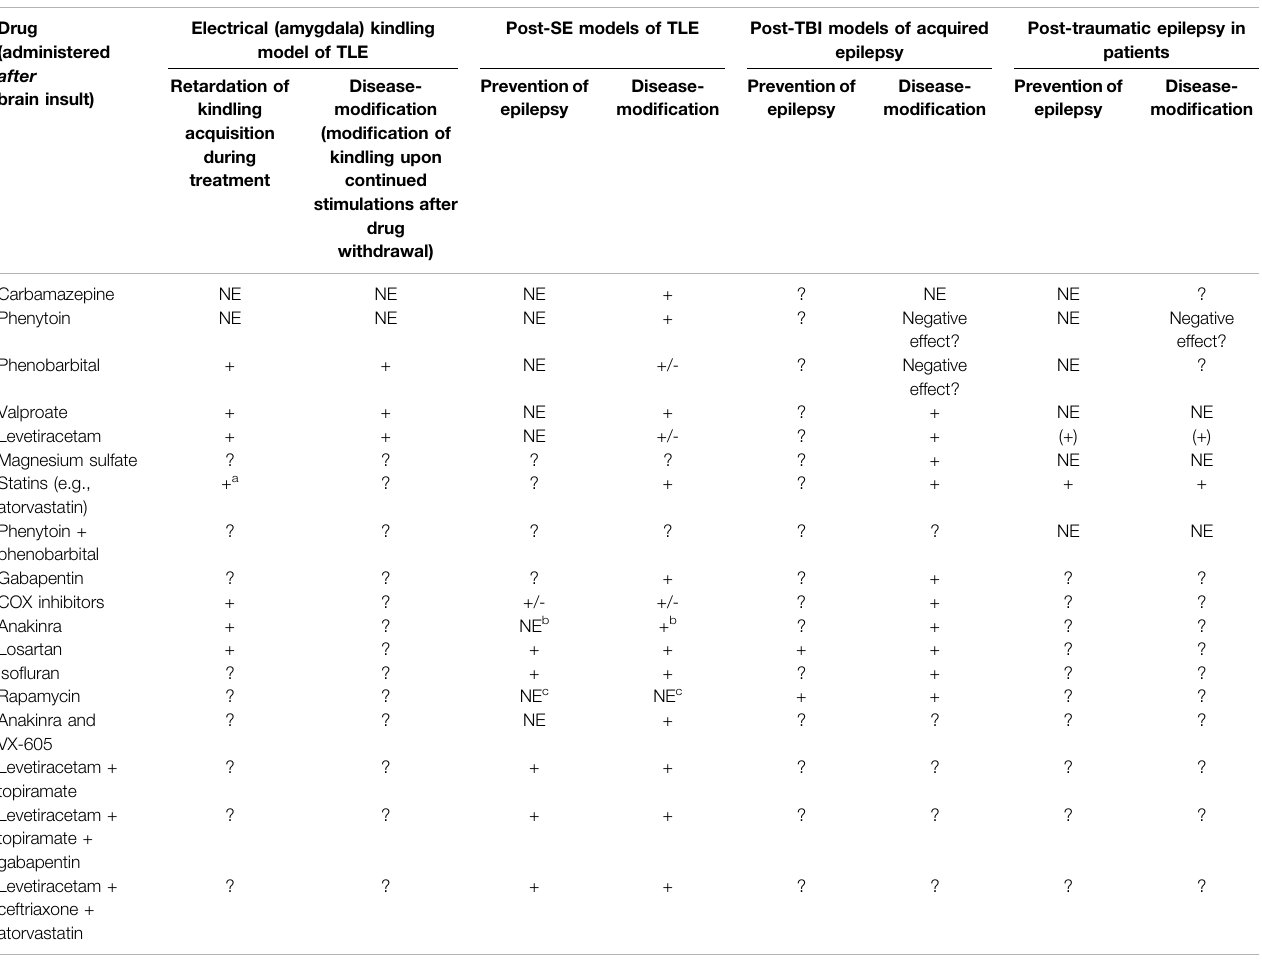
TABLE 4 | Antiepileptogenic and/or disease-modifying effects of selected drugs or drug combinations in chronic rat models of epilepsy and post-traumatic epilepsy prevention trials in humans. Note that, except for VX-605, all drugs shown here are in clinical use for other indications. Drug effect is indicated by + (cid:1) effective; +/-, inconsistent data (+), retrospective clinical data or data from small trials; ? (cid:1) no data available (or found by literature review using Pubmed). For detailed data and references see Löscher (2020) and Löscher and Klein (2021a). Abbreviations: COX, cyclooxygenase; NE, not effective; PTZ, pentylenetetrazole; TBI, traumatic brain injury; TLE, temporal lobe